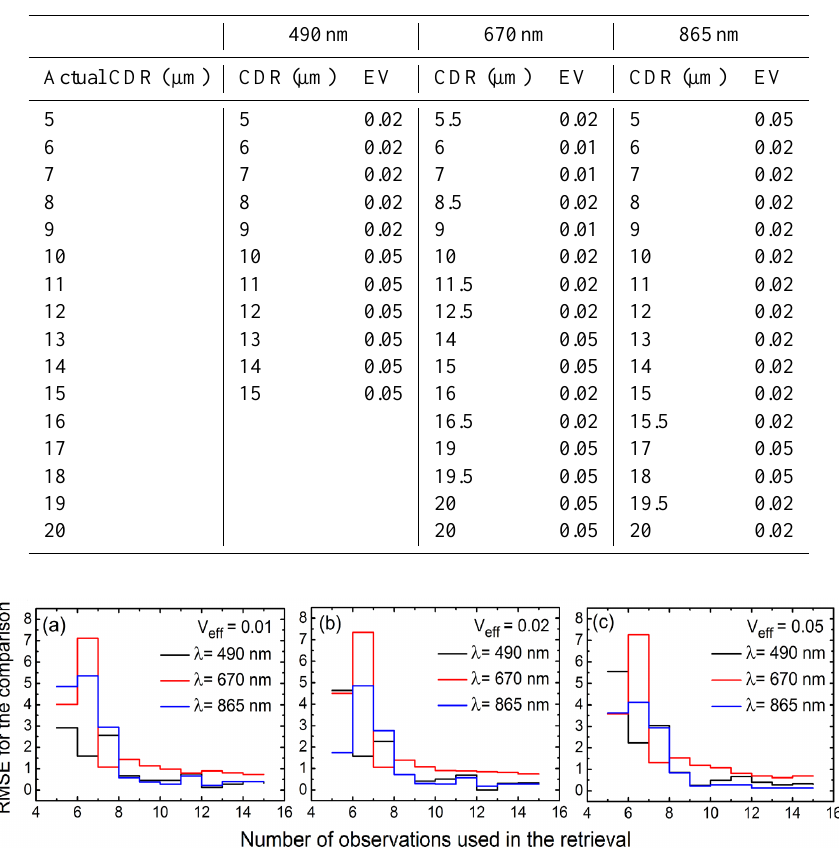
Table 4. Comparison of the CDR and EV retrievals for three wavelengths using 12 observations with the actual EV = 0.02; the COT was assumed to be 5 in all cases. The absence of retrievals for CDR = 16–20µm is due to the Legendre series for cloud fields having effective radii greater than 15µm, which exceeds the limitations of the RT3 model.